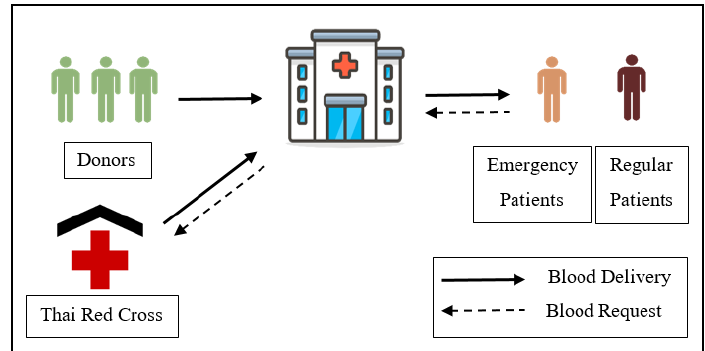
Fig. 1. A schematic diagram of the case study of this research